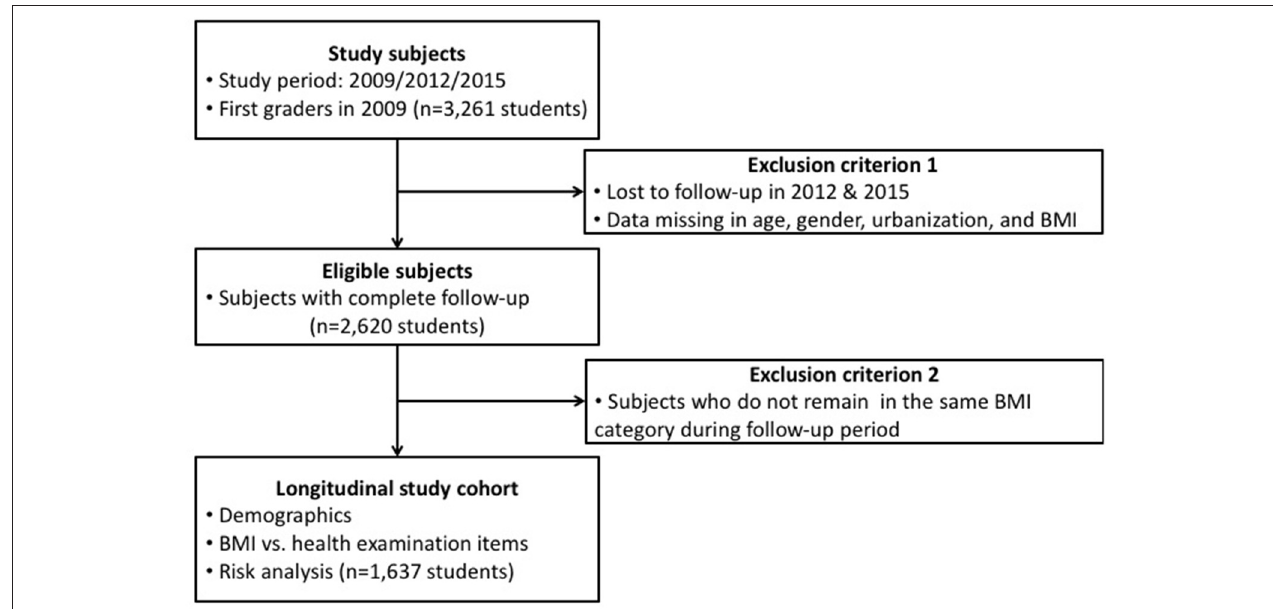
FIGURE 1 | Flowchart of participant recruitment. BMI, body mass